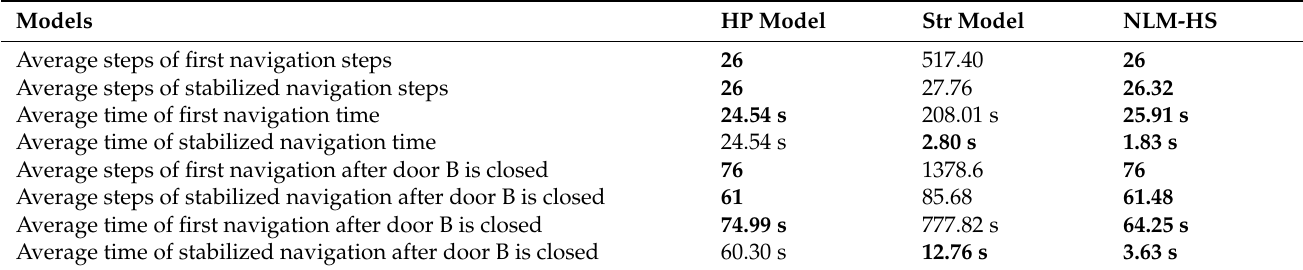
Table 3. Comparison of average navigation results among the three